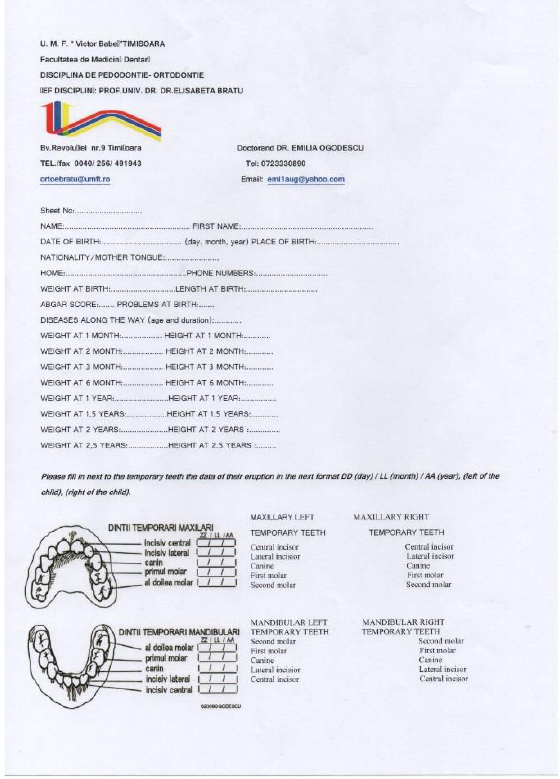
Figure A2. Second page of the questionnaire (used to collect the data for our study).